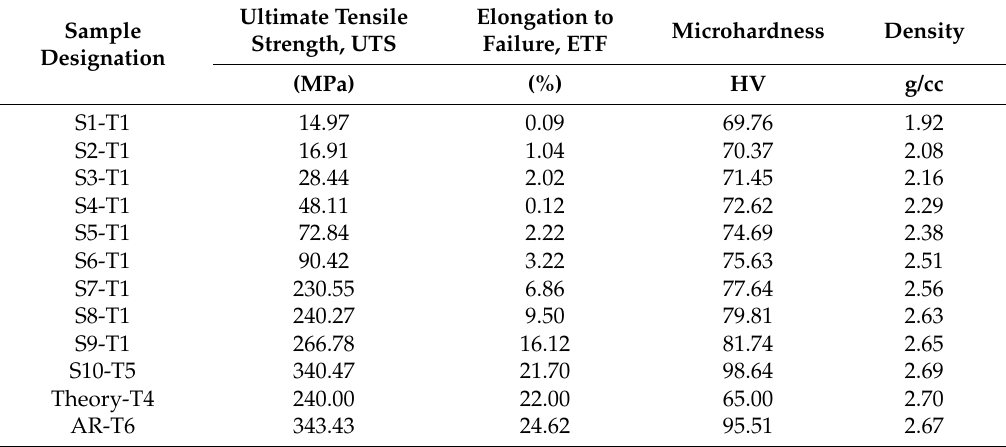
Table 3. Results for tensile properties for all